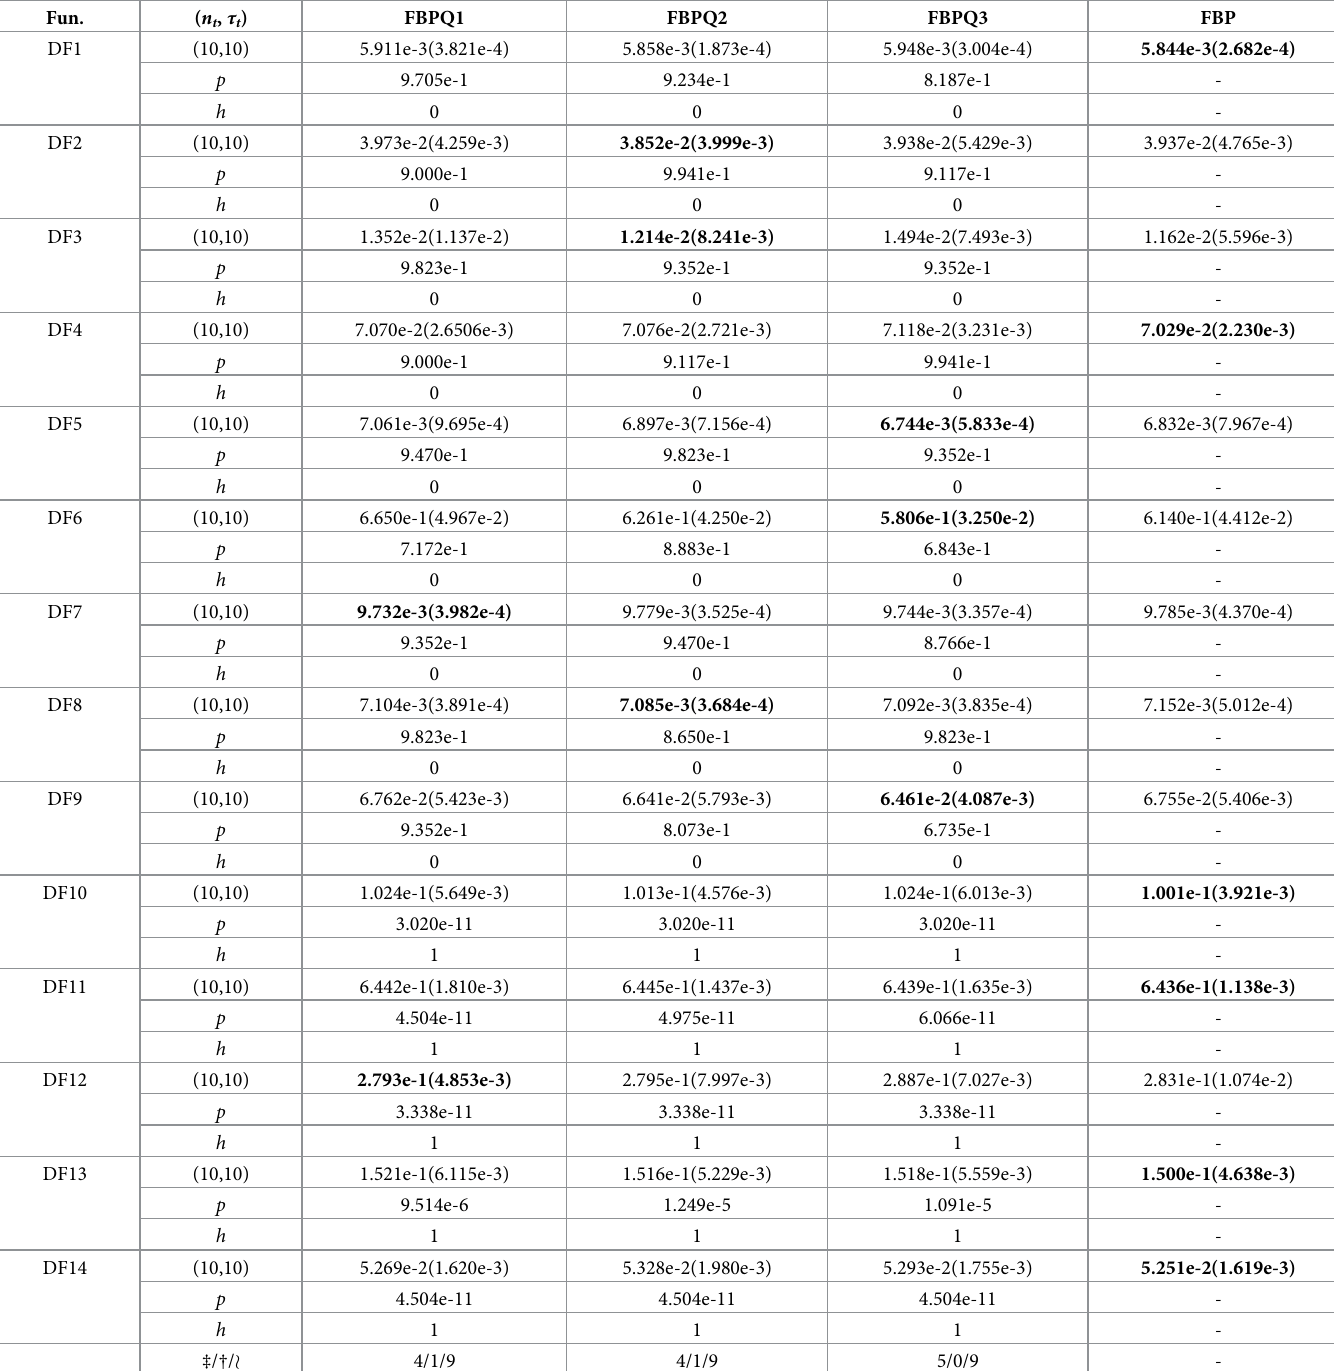
Table 17. Performance comparison of FBP variants on MIGD for ( n t , τ t ) = (10,10).